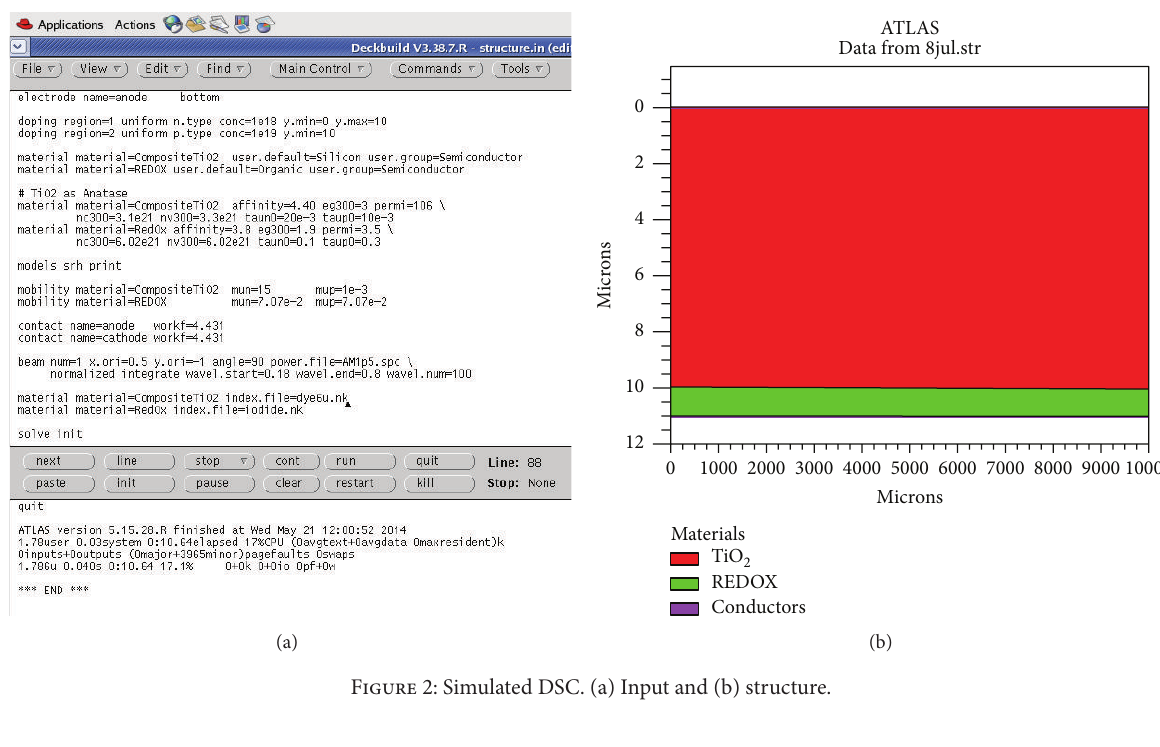
Figure 2: Simulated DSC. (a) Input and (b) structure.